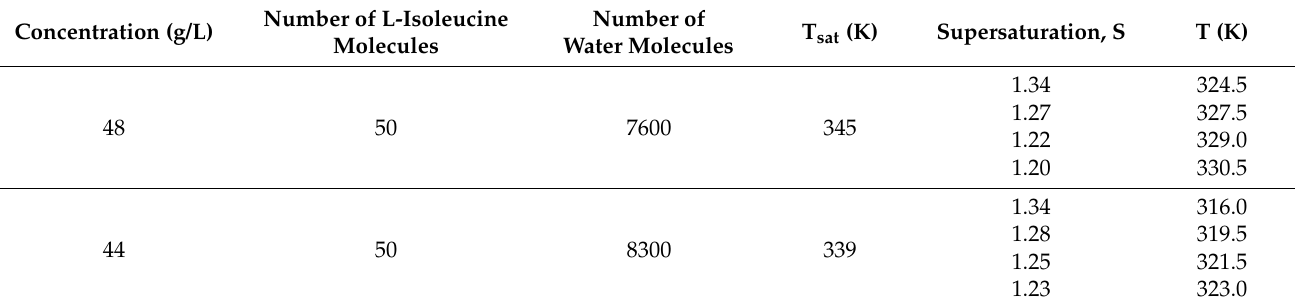
Table 1. The arbitrary cell conditions used in induction time study, showing the number of molecules required to achieve the solution concentration at saturation temperature, Tsat. The temperature, T (K), is the targeted temperature to create supersaturation